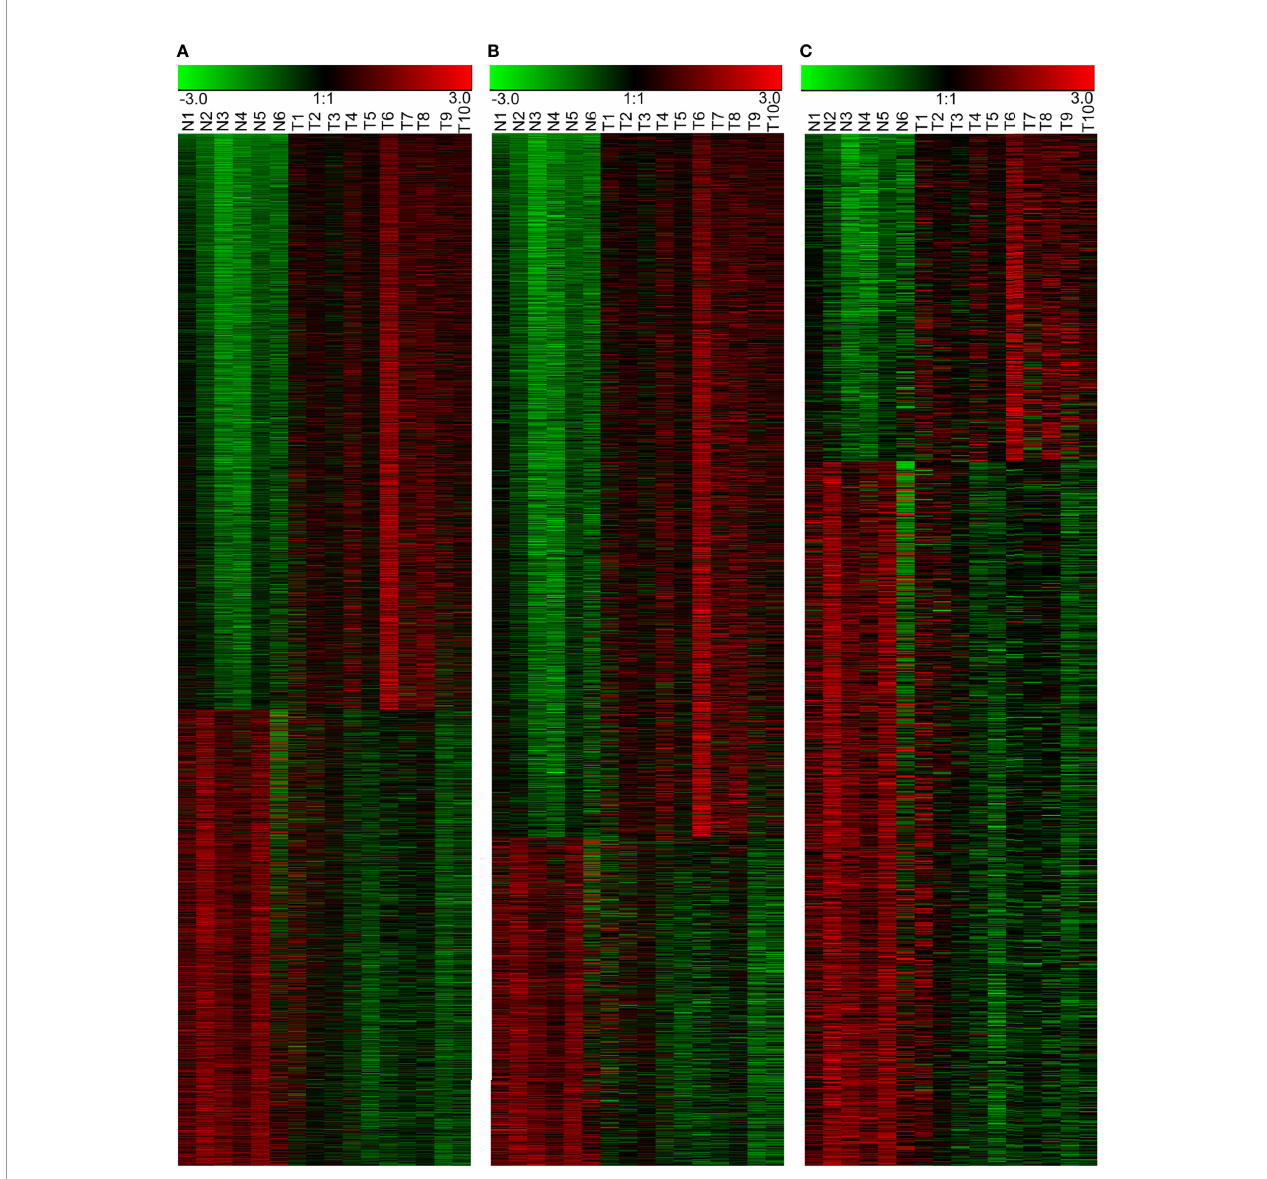
FIGURE 1 | Differentially expressed RNAs in the NPC and the control NPE samples. (A) Heatmap of all differentially expressed RNAs, including lncRNAs and mRNAs. (B) Differentially expressed mRNAs. (C) Differentially expressed lncRNAs. N: normal nasopharyngeal epithelium; T: nasopharyngeal